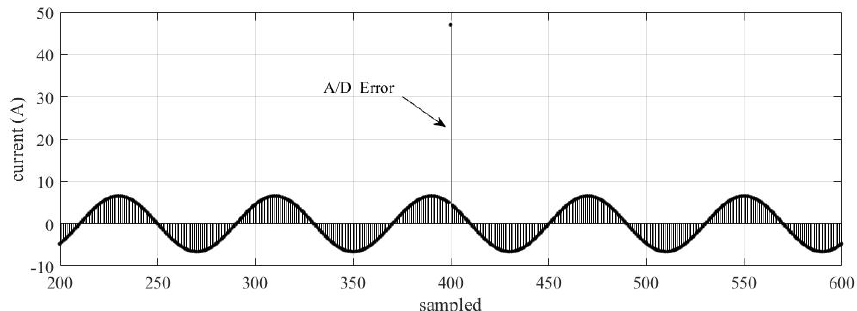
Figure 6. Current signal with A/D error.